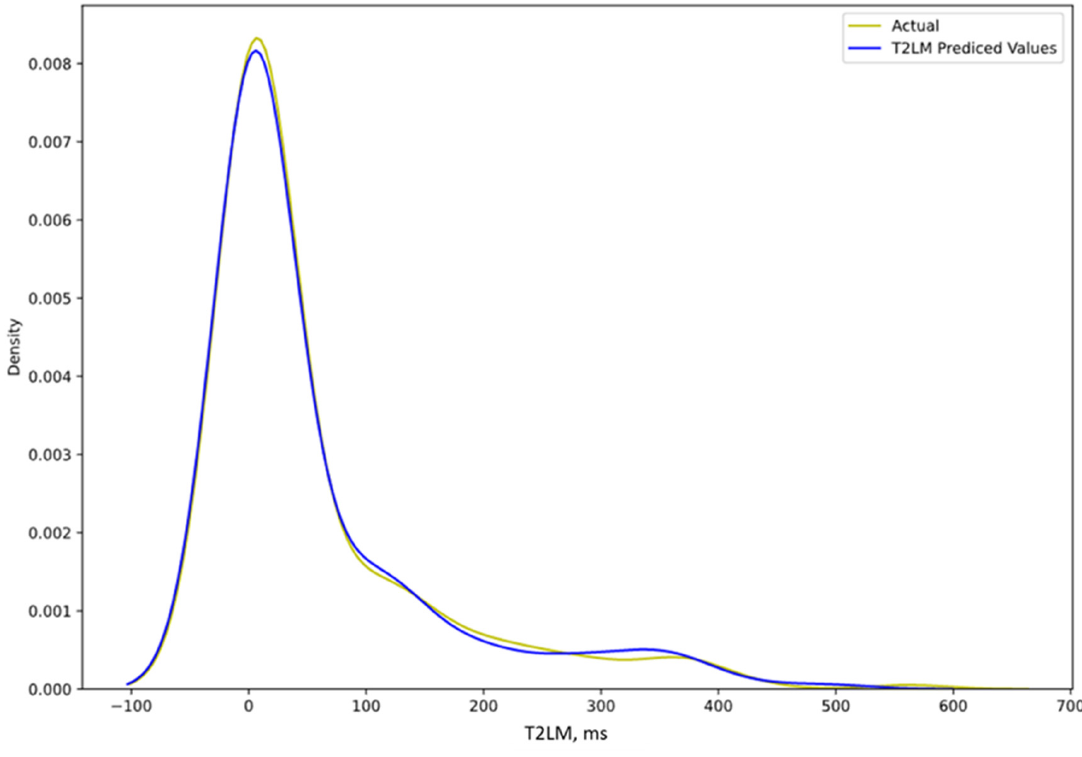
Figure 16. Kernel density estimation showing the closeness of predicted to actual NMR T 2 LM values.